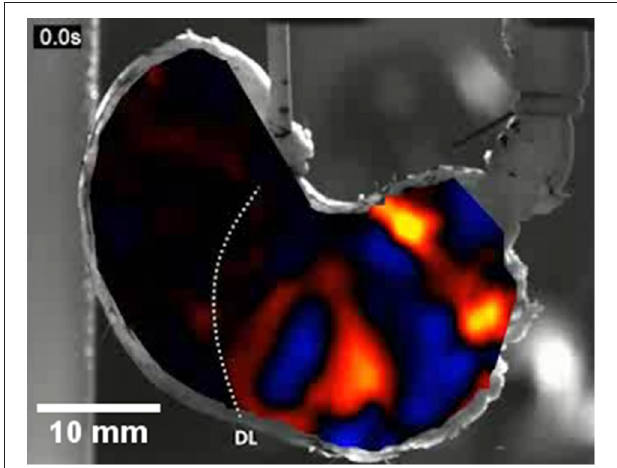
FIGURE 9 | An A-type ST map of area strain rate from antral peristalsis in the stomach of the rat. The pylorus lies on the right and the (cannulated) esophagus is situated at the top slightly to right of the midpoint. The area strain rate map is overlaid onto, and synchronous with, the image from which it is derived. Note the randomly dispersed carbon particles on the areas to the side of the A-map which are also in the area under the map and were used as reference points. The succession of areas of high negative strain rate (yellow and red) are sites undergoing antral peristalses. The areas of positive strain rate (blue) correspond to areas of relaxation. The dotted line marked DL indicates the position of the line of demarcation between the fundus and body, which is anatomically evident in rats. Note the increase in the magnitude of area strain as the contractions near the pylorus and the failure of antral peristalses to extend to the lesser curve in the proximal corpus and antrum. Modified figure from Lentle et al.